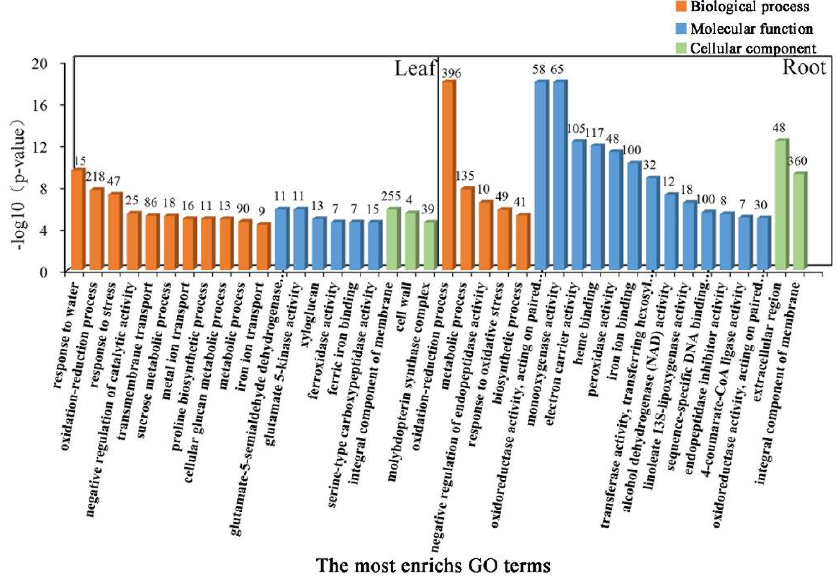
Figure 5. Gene Ontology (GO) enrichment analysis of DEGs. Genes were assigned to three main categories: Biological process, Molecular function, and Cellular component. The names of the GO categories are listed along the x-axis. The degree of GO enrichment is represented by the false discovery rate (FDR) value and the number of genes enriched in each category. The FDR value indicates the corrected P -value, ranging from 0 to 1, and an FDR value closer to 0 indicates greater enrichment.